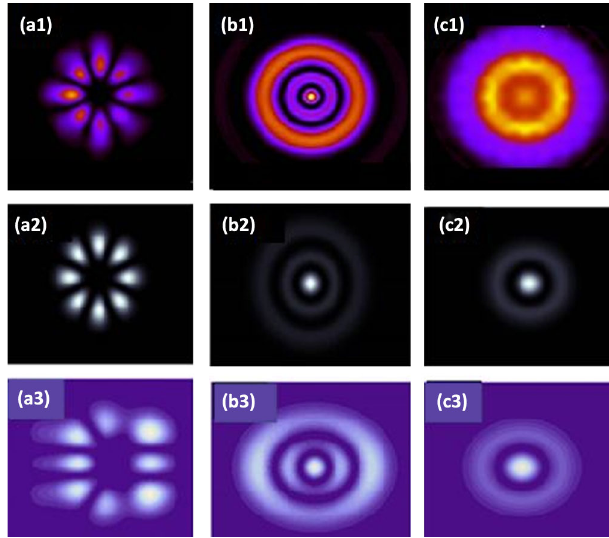
FIG. 15. Mode profiles obtained from the simulations (first row), from a Gauss-Laguerre expansion (second row), and from a Gauss-Hermite expansion (third row); (a) intermediate configu- ration ( g ¼ − 0 . 6 ), 10 μ m wavelength, 4 mm hole size, (b) inter- mediate configuration ( g ¼ − 0 . 9 ), 25 μ m wavelength, 1 mm hole, and (c) confocal configuration ( g ¼ 0 ), 50 μ m wavelength, 1 mm hole. Details of the mode expansions are given in Table II. For each plot the window size is 50 mm by 50 mm.